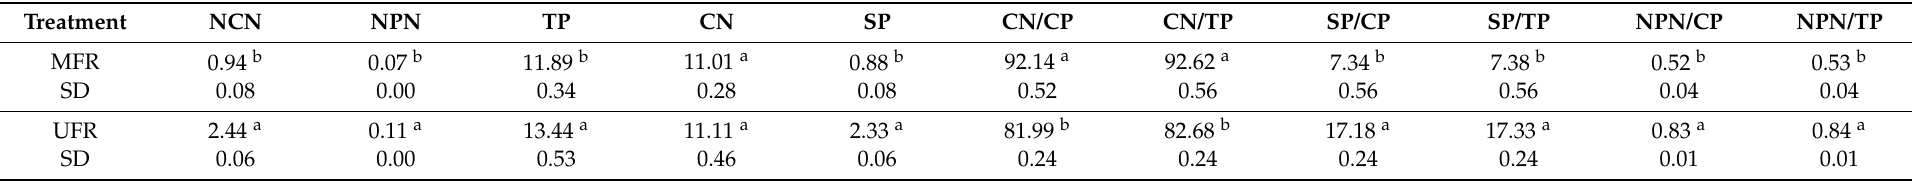
Table 3. Mean ( n = 3) retentate (MFR 1 and UFR 2 ) protein content and various protein ratios (% by weight) produced during microfiltration and ultrafiltration of skim milk using polymeric spiral-wound membranes. Treatment